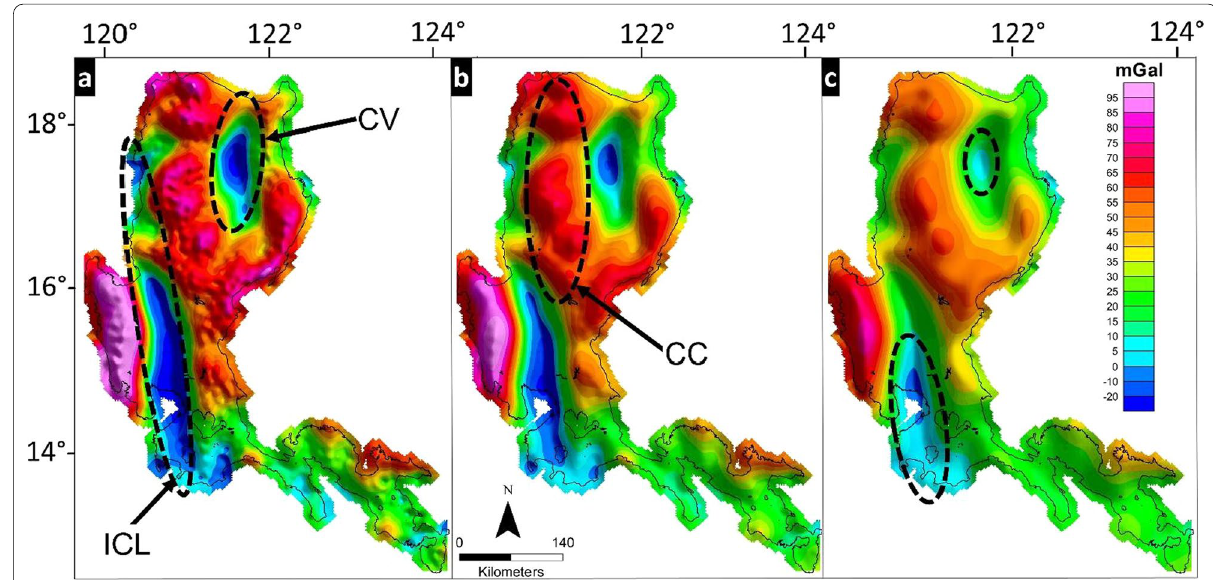
Fig. 6 Upward continued maps of Luzon Island at 5, 10, and 20 km representing minimum depths of a 2.5, b 5, and c 10 km, respectively. The magmatic belts separate Ilocos-Central Luzon Basin (ICL) and Cagayan Valley Basin (CB) along Central Cordillera (CC) (MGB 2010). c Very low-gravity anomaly zones (< 5mGal) indicate portions of the basins with thickest sediment accumulation (e.g., Tamesis 1976; Bachman and Lewis 1983)